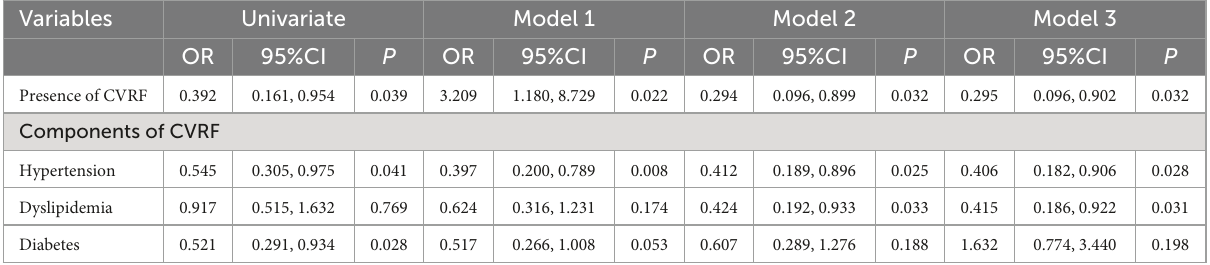
TABLE 2 Multiple logistic regression analysis of presence and components of CVRF for elderly patients with sarcopenia. Variables